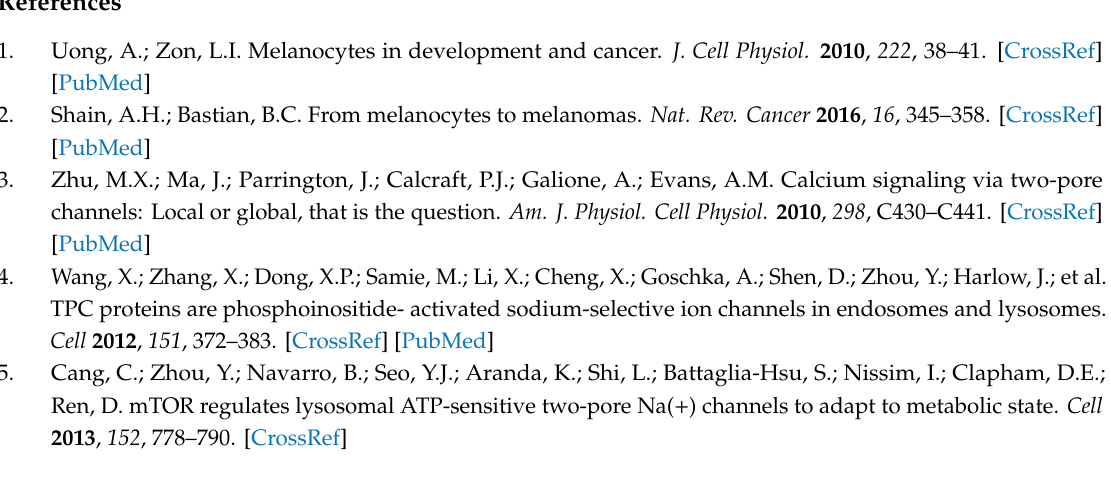
Figure S1: YAP / TAZ target genes’ induction in B16-F0 murine cell line, Figure S2: Ultra low attachment conditions, Figure S3: Correlation analysis between TPCN2 and Vimentin; MITF; ZEB1; CTGF; ANKRD1; CYR61; CHD-2(N-Cadherin); MMP9 in primary patients in human skin melanoma TCGA database, Figure S4: Correlation analysis between TPCN2 and Vimentin; MITF; ZEB1; CTGF; ANKRD1; CYR61; CHD-2(N-Cadherin); MMP9 in metastatic patients in human skin melanoma TCGA database, Table S1: Statistical analysis of TPC2 and other genes’ correlation in skin melanoma TGCA